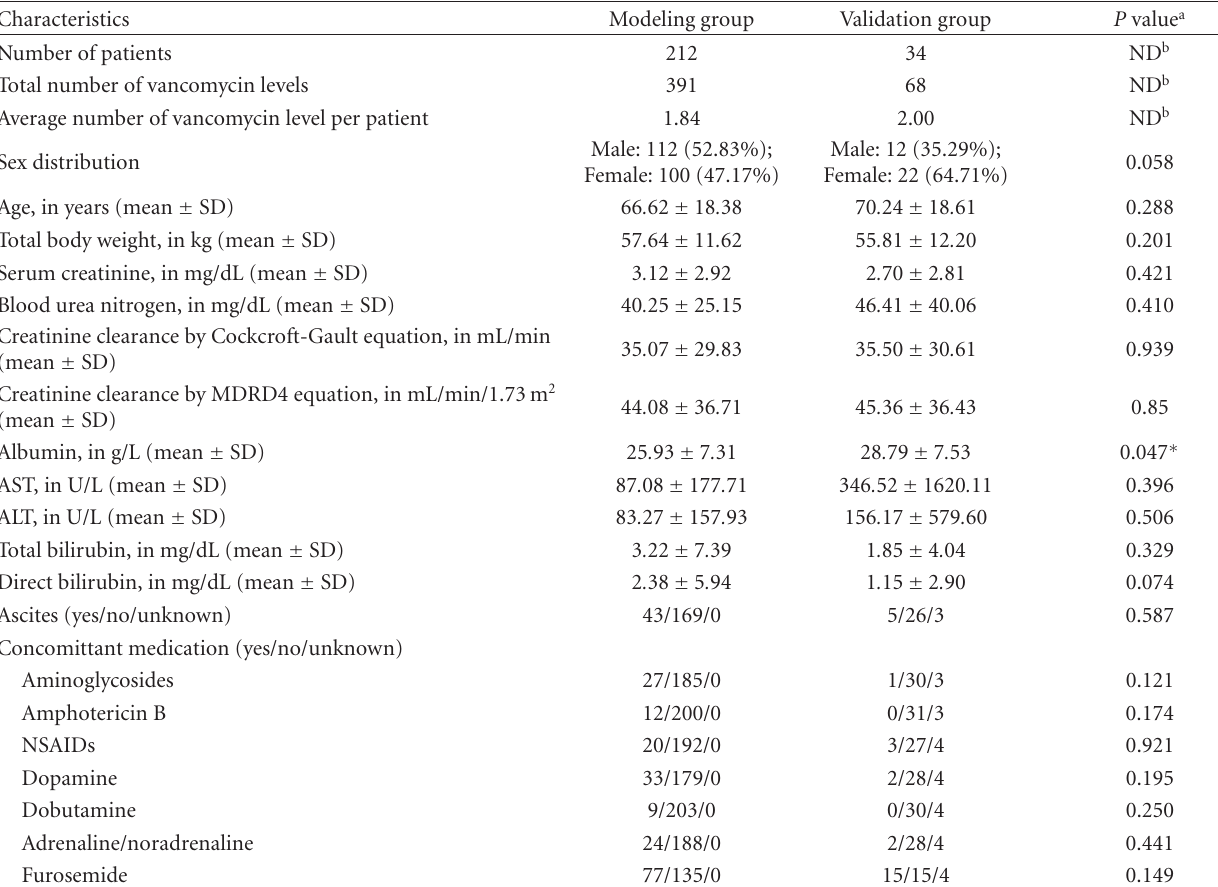
Table 1: Summary of demographic and clinical characteristics of the patients in the modeling group and the validation group.